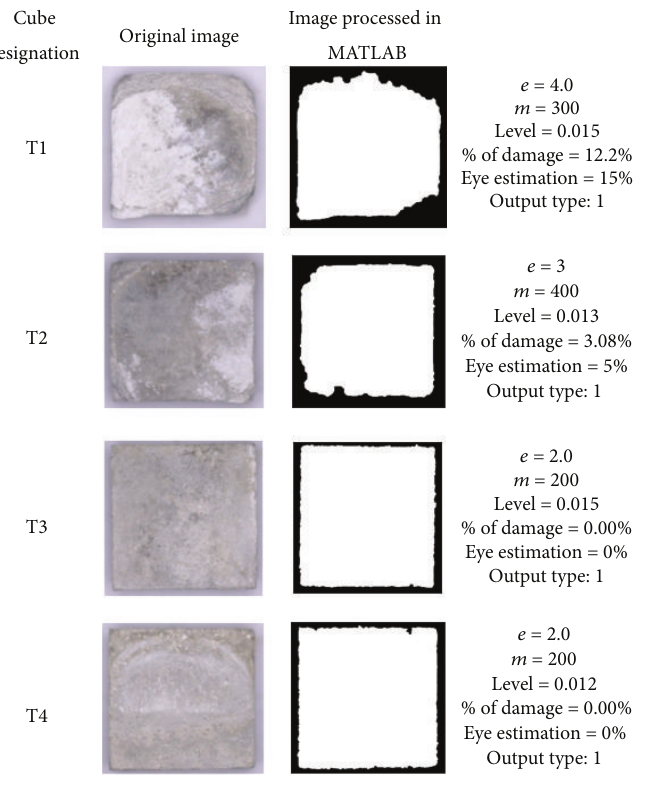
Figure 9: Surface area damage after submergence for 90 days.